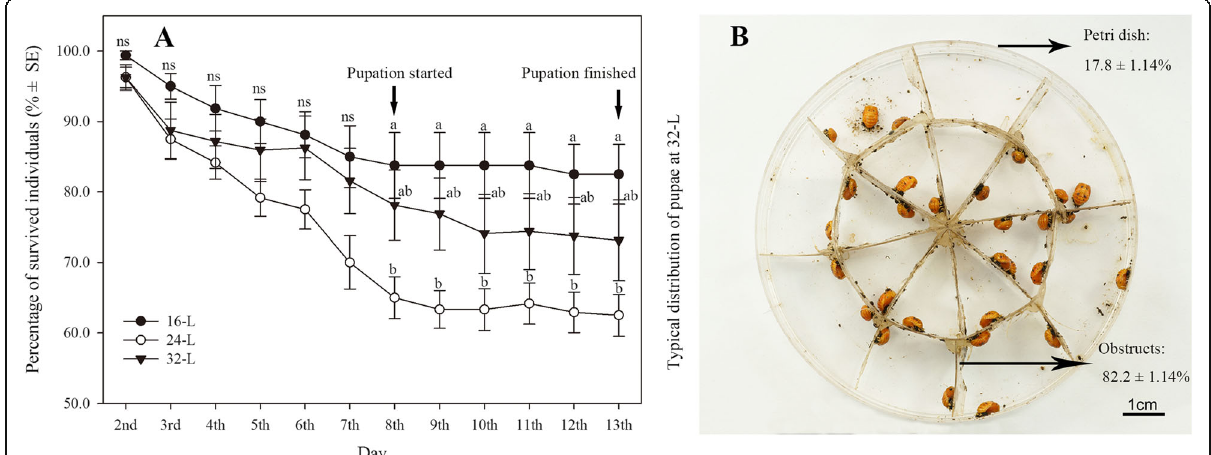
Fig. 4 Percentage of survived individuals in Con-C units with 16-L, 24-L, and 32-L densities ( A ), and the typical distribution pattern of pupae at the 32-L density ( B ). The individual pupation started at the 8th day after rearing and all larvae entered into pupa stages at the 13th day after rearing. Different letters indicated significant differences among the three rearing densities on the same day; ns indicates no significant difference. The averages on obstruct and on Petri dish (sum of the data from bottom, wall, and lid) are displayed ( B )